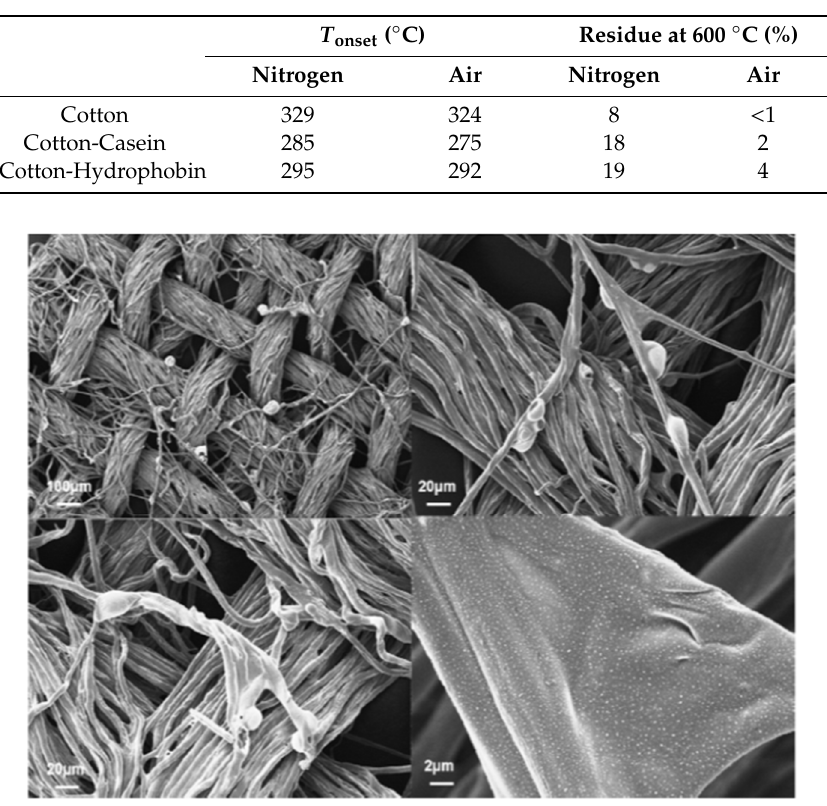
Figure 9. Hydrophobin-treated cotton residue SEM [36].